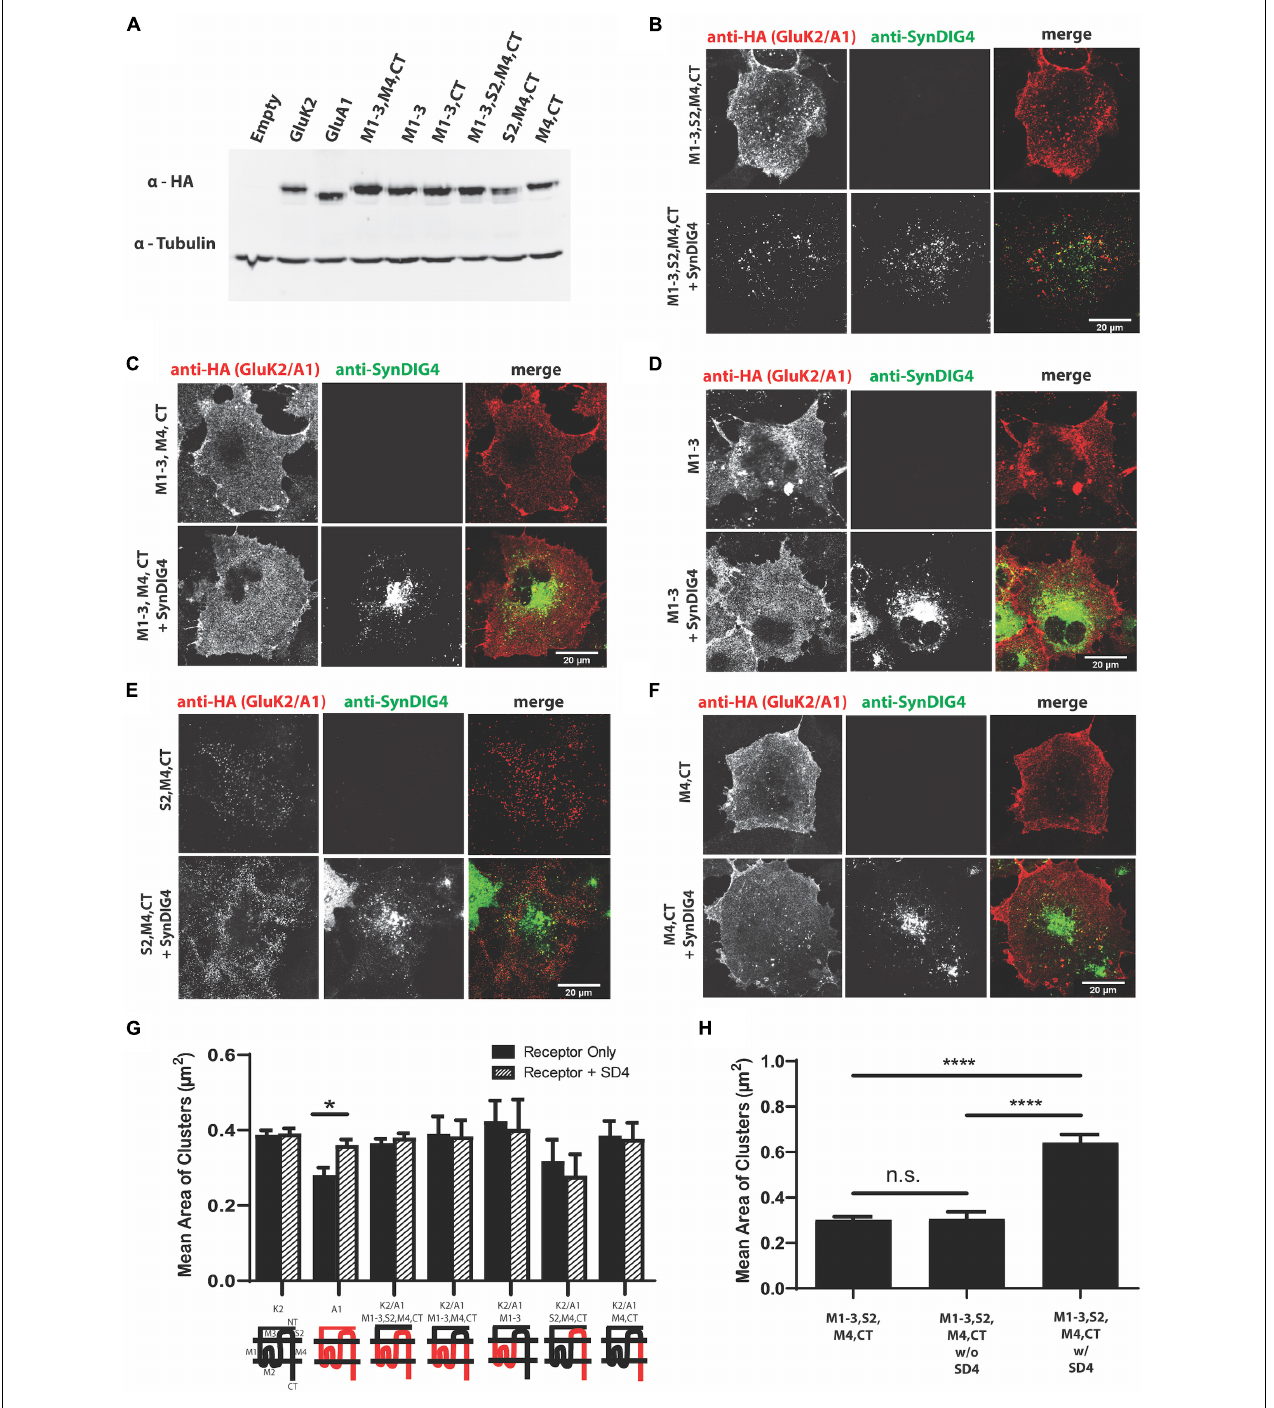
FIGURE 3 | The N-terminus of GluA1 is dispensable for clustering with SD4. (A) Immunoblot depicting expression of GluK2/GluA1 chimeras. Homologous domains of GluA1 were inserted into the backbone of GluK2 (as shown in Table 2 of Methods). β -tubulin was used as the loading control. (B–F) Representative confocal images of COS cells transfected with either a GluK2/A1 chimeric receptor alone, or co-transfected with SD4. Scale bar = 20 µ m. (G) Graph depicts the mean area of clusters when GluK2, GluA1, and each GluK2/A1 chimera is expressed either alone or co-expressed with SD4. (H) Graph depicts the mean cluster size of M1-3, S2, M4, CT chimera stratified for either co-localized or not co-localized with SD4. M1-3, S2, M4 alone ( n = 11), M1-3, S2, M4 w/o SD4 ( n = 13), M1-3, S2, M4 w/ SD4 ( n = 13). Data are represented as mean ± SEM; n.s. not significant; * p < 0.05; **** p < 0.0001; one-way ANOVA with post-hoc Tukey’s test.